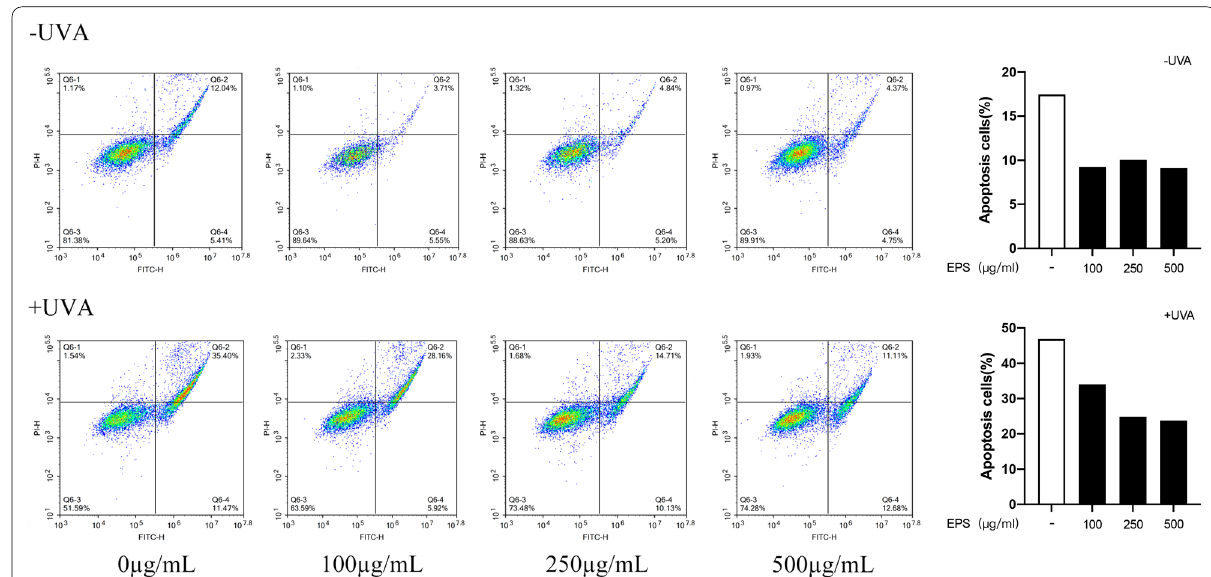
Fig. 2 Effects of different concentrations of EPS on HSF apoptosis under normal conditions and after UVA